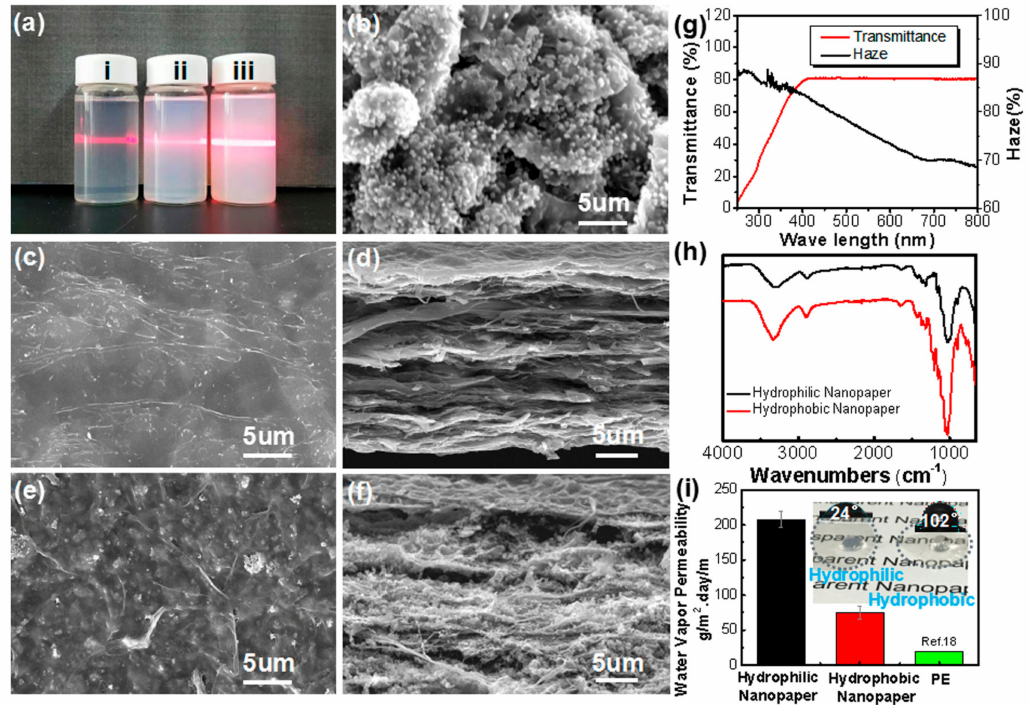
Figure 4. Characterization of the hydrophobic nanopaper: ( a ) the suspending liquid of nanocellulose (i), nano-SiO 2 (ii), and the mixed nanocellulose-SiO 2 (iii); ( b ) the SEM morphology of the nano-SiO 2 dispersed on nanocellulose matrix; ( c ) the facial SEM morphology of the pure nanopaper; ( d ) the cross-sectional SEM morphology of the pure nanopaper; ( e ) the facial SEM morphology of the hybrid nanopaper; ( f ) the cross-sectional SEM morphology of the hybrid nanopaper; ( g ) the transparency and haze of the hydrophobic nanopaper; ( h ) FTIR spectra of the pure nanopaper and the hybrid hydrophobic nanopaper; ( i ) digital photo of water droplets on surfaces of the hydrophilic and hydrophobic